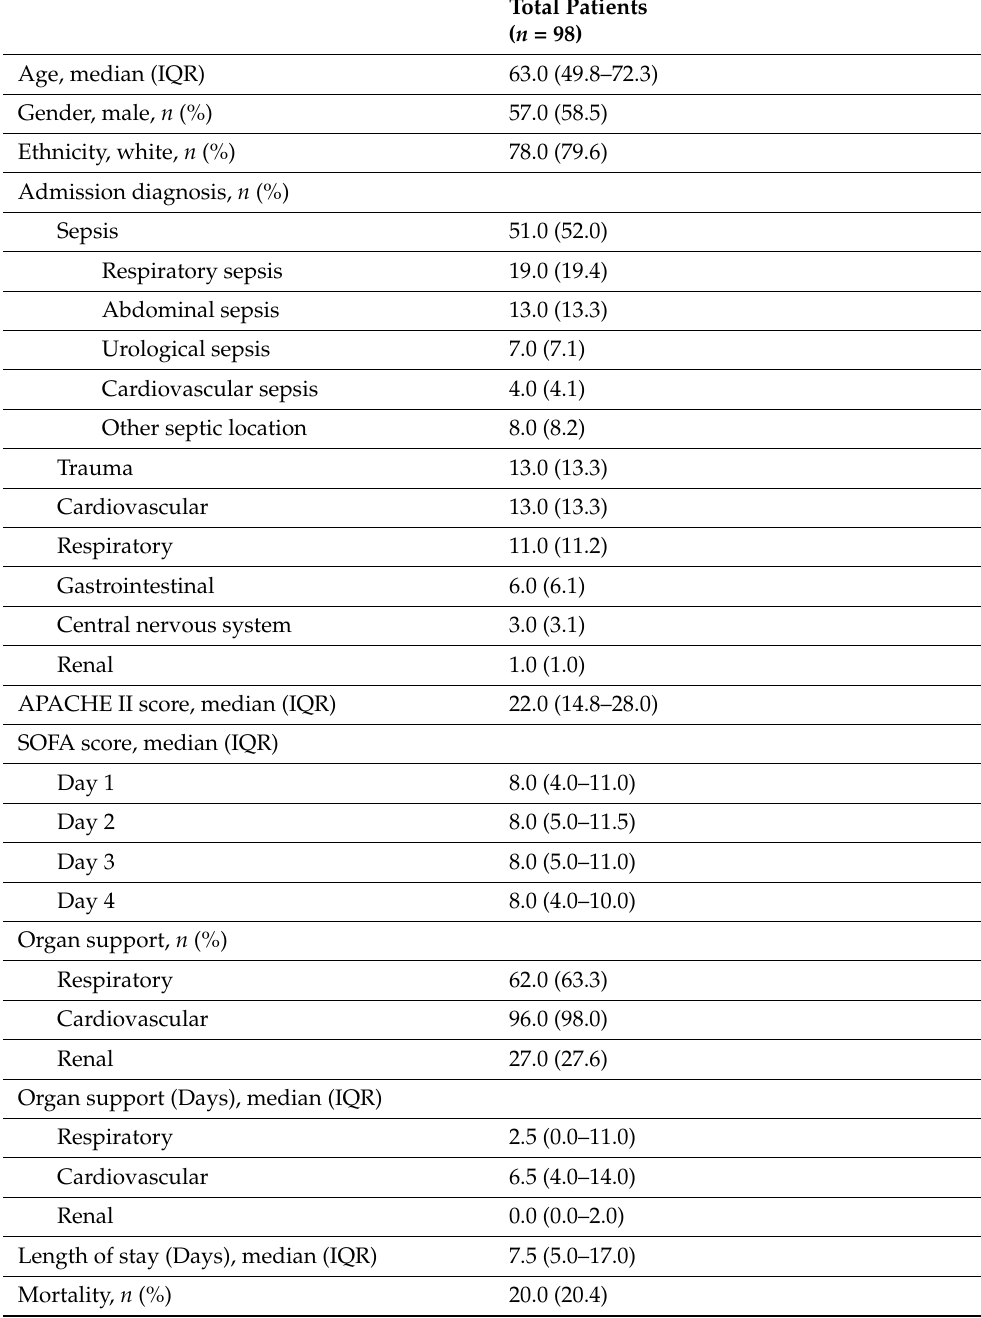
Table 1. Patient Summary